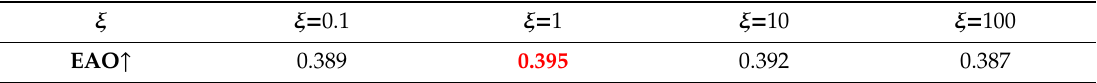
Table 5. Tracking results of EAO on the VOT-2018 benchmark using di ff erent values of ξ in Equation (4). The best results are highlighted in red fonts.